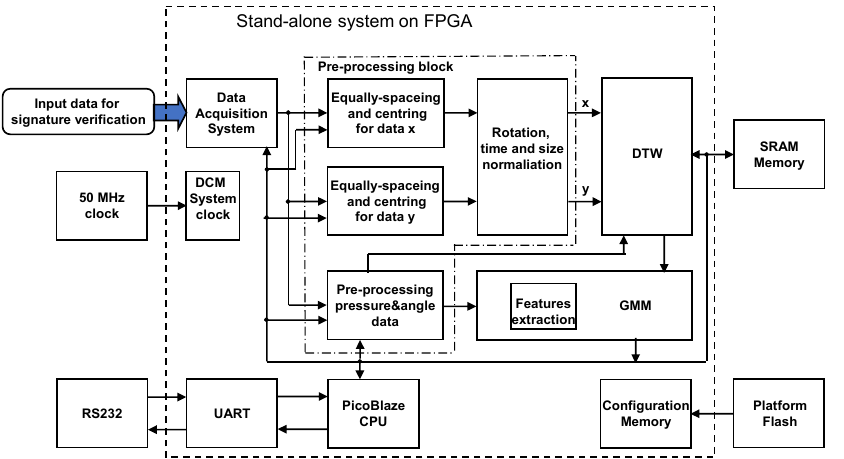
Figure 6. Architecture overview of the customized system.